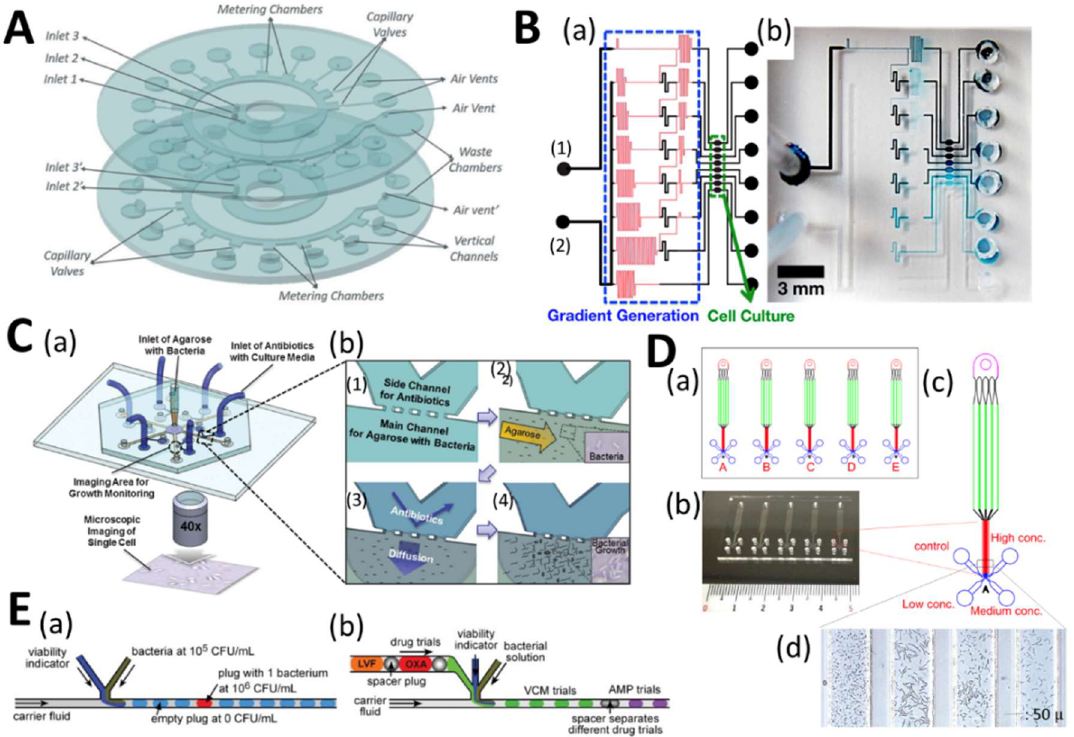
Figure 1. ( A ) An automated linear concentration gradient generator based on centrifugal microfluidics for antibiotic susceptibility testing (AST). The operation is based on the use of multi-layered microfluidics in which individual fluidic samples to be mixed together are stored and metered in their respective layers before, finally, being transferred to a mixing chamber. Reprinted with permission from [148]; ( B ) ( a ) The microfluidic microchip design: Black and red channels represent 149-μm and 4-μm tall features, respectively; ( b ) A photograph of the fabricated PDMS chip. Blue food dye solution and water were injected to upper (1) and lower (2) inlet ports. ( a ) Reprinted with permission from [145]; ( C ) Schematic diagram of the AST process for the microfluidic agarose channel (MAC) system. ( a ) The MAC chip was fabricated with PDMS on glass. An agarose–bacteria mixture solution was injected into the center of the chip, which flowed synchronously into the six main channels. Each interface between the agarose with the bacteria and antibiotic solutions was monitored microscopically to analyse bacterial cell growth. ( b ) (1) The empty channel before AST. (2) The bacteria were mixed with agarose and then injected into the main channels. (3) A sharp interface was generated due to the anchors and then liquid medium with different concentrations of antibiotic. (4) Time-lapse microscopic observation of a bacterial cell. Reprinted with permission from [153]; ( D ) The structure of the AST microfluidic device for MIC determination of five drugs. ( a ) Design. ( b ) Actual image. ( c ) Precise structure of one set of fluids. ( d ) Microscopic image of Pseudomonas aeruginosa grown in the presence of piperacillin. Reprinted with permission from [158]; ( E ) Stochastic confinement of bacteria into plugs. ( a ) Schematic drawing illustrates the increase in cell density, resulting from the stochastic confinement of an individual bacterium in a nanoliter-sized plug. ( b ) Screening of many antibiotics against the same bacterial sample. Antibiotics: Ampicillin (AMP), levofloxacin (LVF), vancomycin (VCN), and oxacillin (OXA). Reprinted with permission from [152].